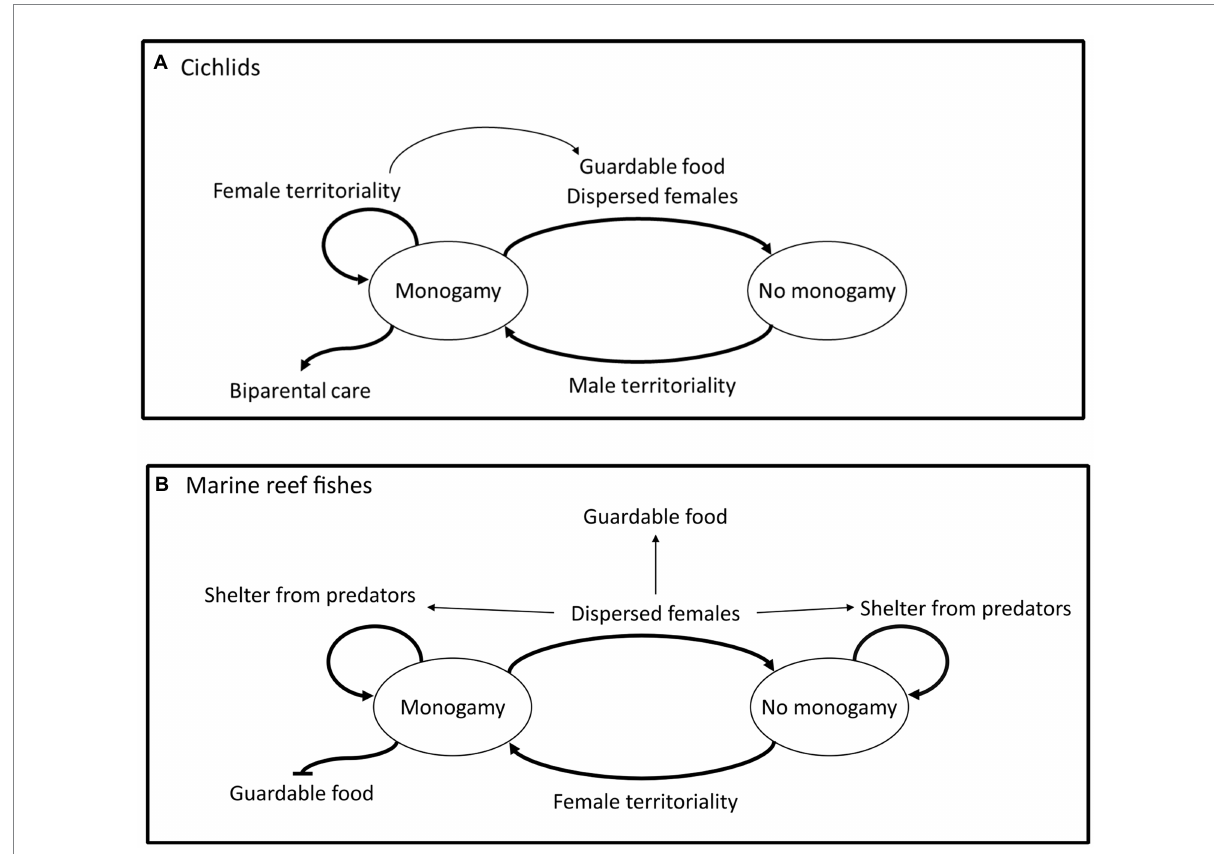
FIGURE 2 Summary of the discrete analyses which found strong evidence of directional correlated evolution between traits in cichlids (A) , and in marine reef fishes (B) . Thicker arrows indicate evolutionary transitions directly related to monogamy; traits placed by the thicker arrows are likely driving these transitions. For example, in cichlids male territoriality drives the evolution and maintenance of monogamy from non-monogamy and the evolution of biparental care is driven by monogamy. Thinner arrows represent evolutionary transitions between traits other than monogamy, for example, in cichlids female territoriality drives the evolution of a diet of guardable